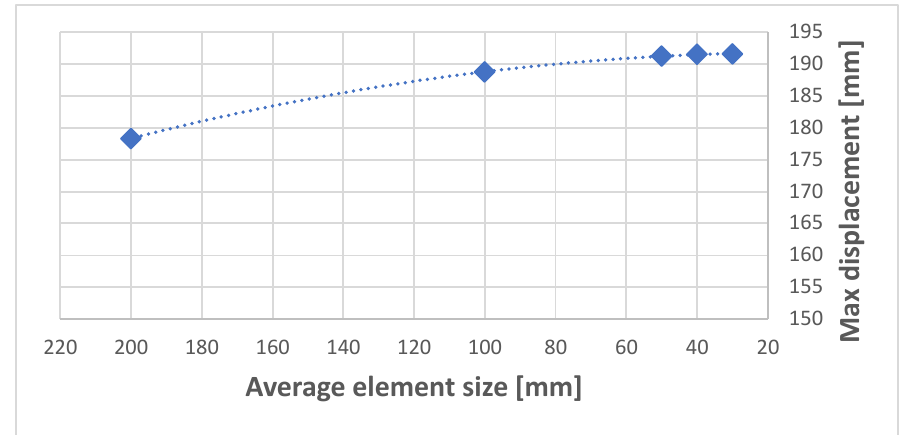
Figure 11 . Plot of the maximum displacement vs. average element size. Figure 11. Plot of the maximum displacement vs. average element